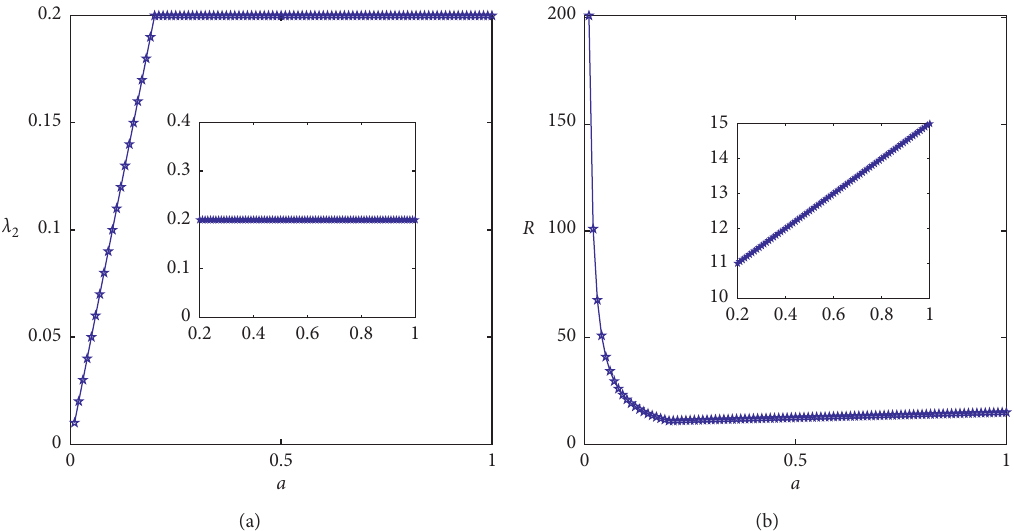
Figure 6: When N is even, the synchronizability of Network I changes with the intralayer coupling strength a from the leaf nodes to the hub changes with a ( a changes from 0.01 to 1) (subgraph: λ nodes. (a) λ 2 changes from 0.01 to 1) (subgraph: R changes with a ( a changes from 0.2 to